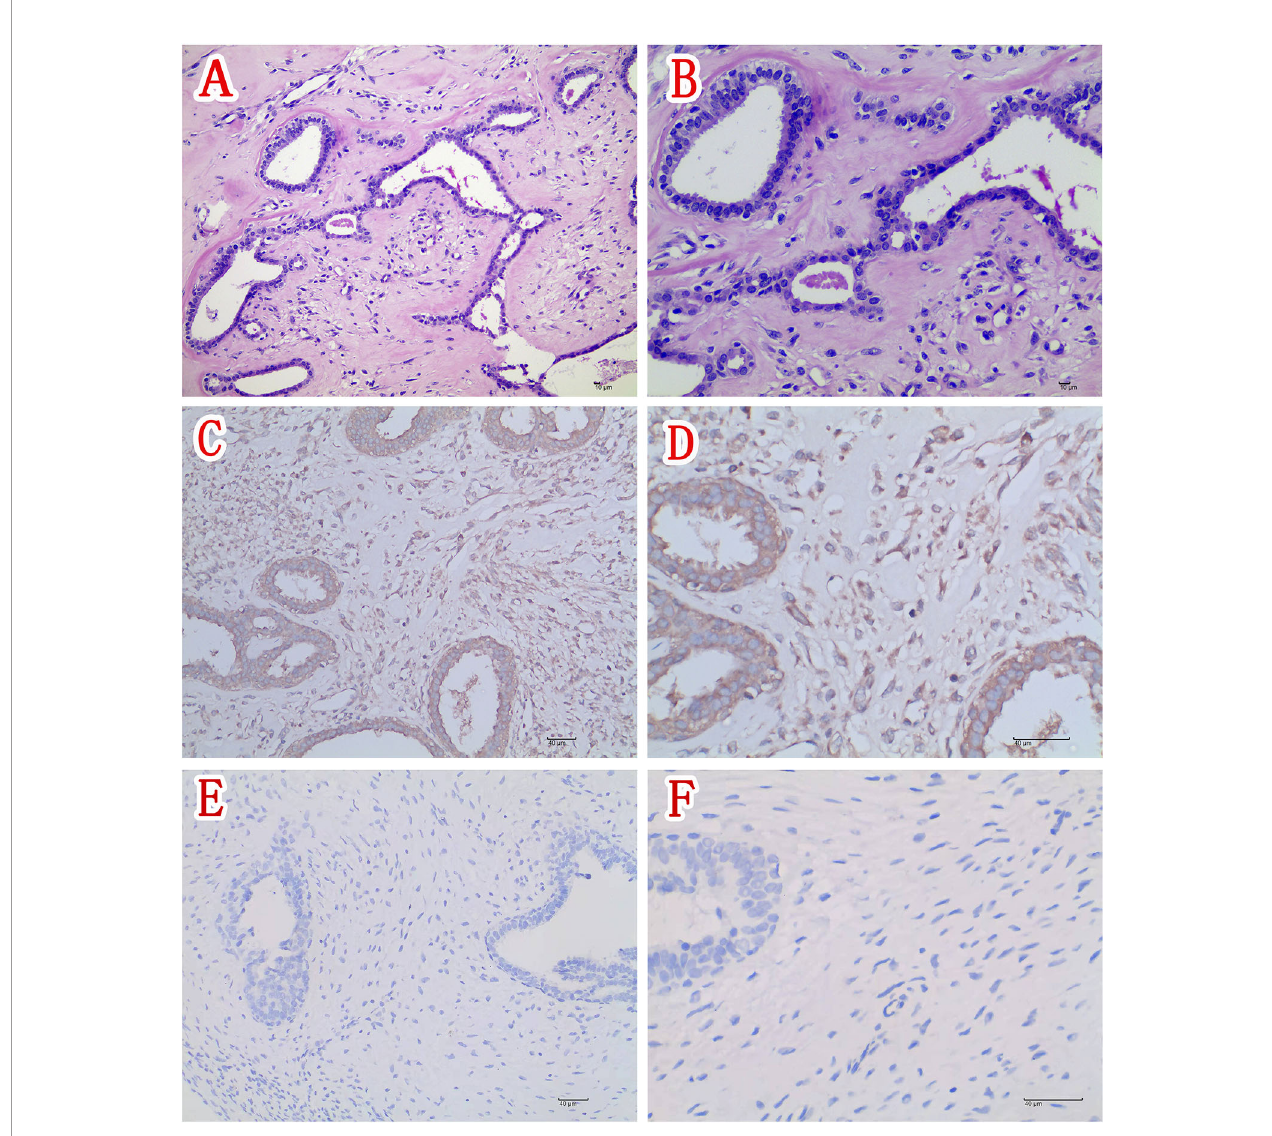
IHC ×200) and (D) higher magni fi cation of the phyllodes tumor depicted in panel (C) showing positivity for IGF-2 in the cytoplasm of tumor mesenchymal cells and ductal epithelium (IGF-2 IHC ×400). (E) Immunohistochemical staining of the control phyllodes tumor of breast obtaining from another woman without hypoglycemia (IGF-2 IHC ×200) and (F) Higher magni fi cation of the phyllodes tumor depicted in Figure 2E showing negativity for IGF-2 in the control tumor tissue (IGF-2 IHC